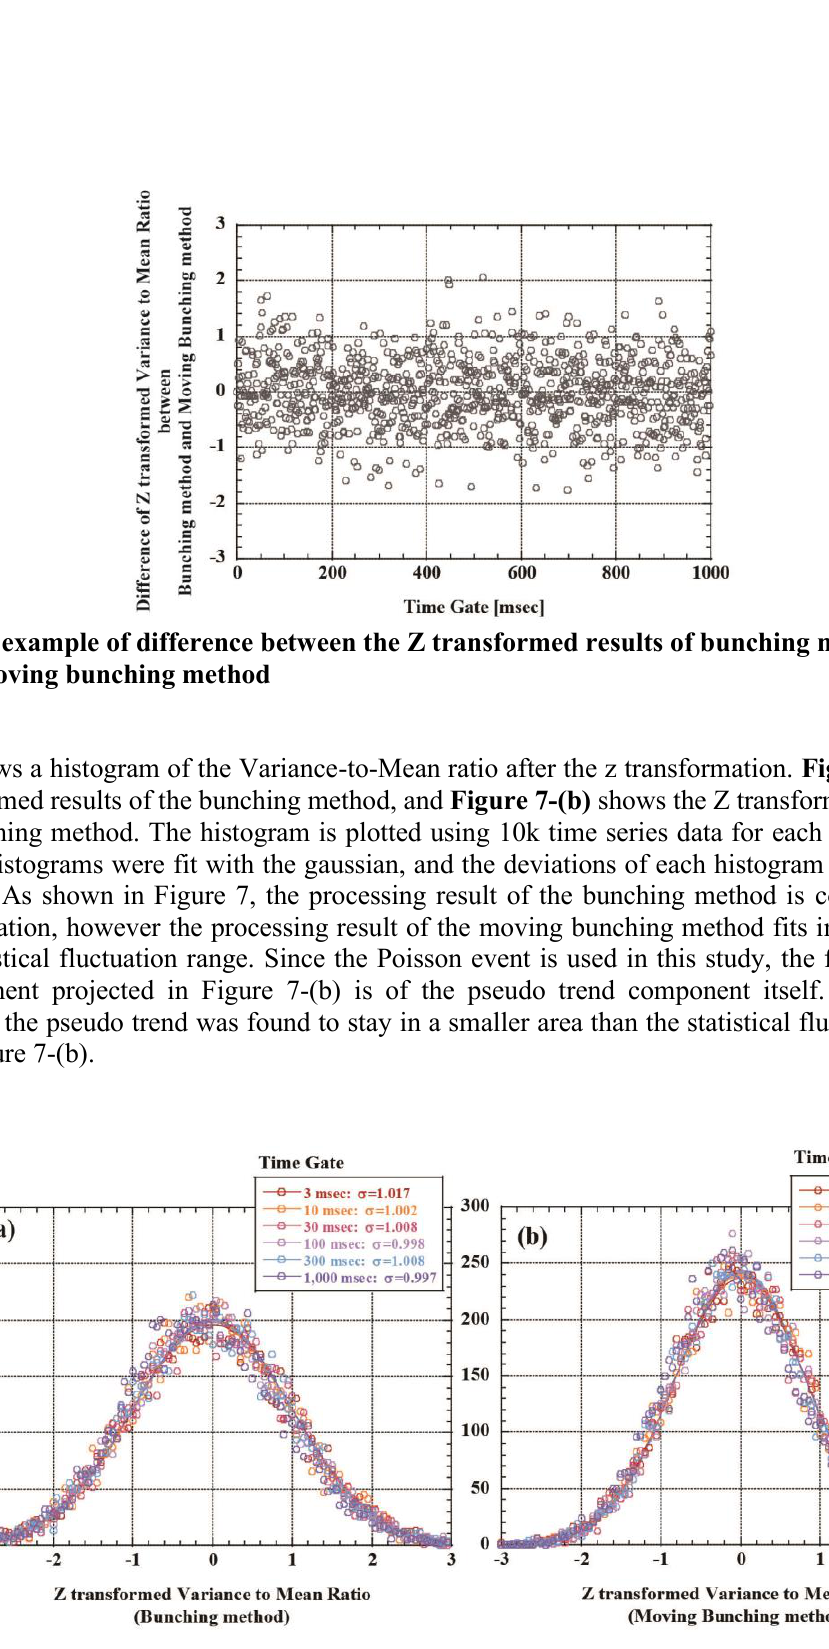
Figure 7. Histograms of the Z transformed Variance-to-Mean